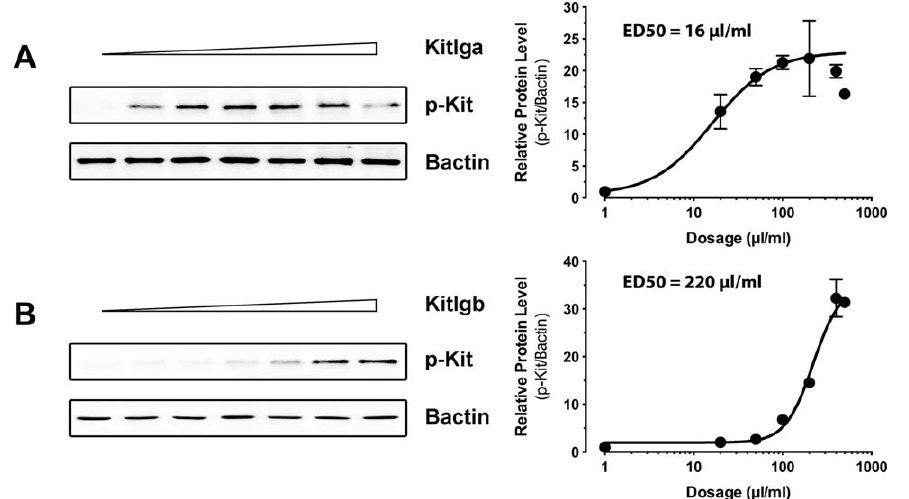
Figure 5. Dose response activation of Kita and Kitb by Kit ligands. The COS-1 cells expressing Kita and Kitb were treated with conditioned media containing recombinant Kitlga (A) and Kitlgb (B) for 10 min followed by Western blot analysis for Kit phosphorylation (left) and characterization of Kitlga and Kitlgb potency (right). The ED50 for each ligand was defined as 1 Unit. p-Kit, Kit phosphorylation.